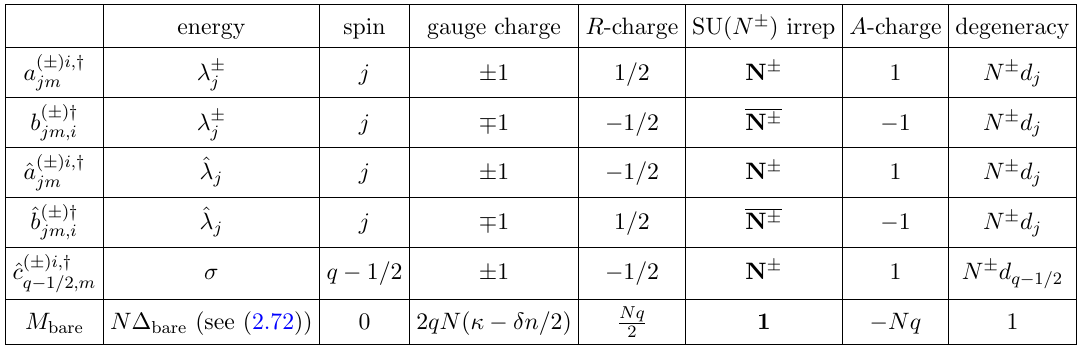
Table 5 . Properties of modes for the (cid:6) charged chiral (cid:12)eld and the bare monopole for N = 2 SQED 3 for (cid:27) > 0. For (cid:27) < 0 see the discussion